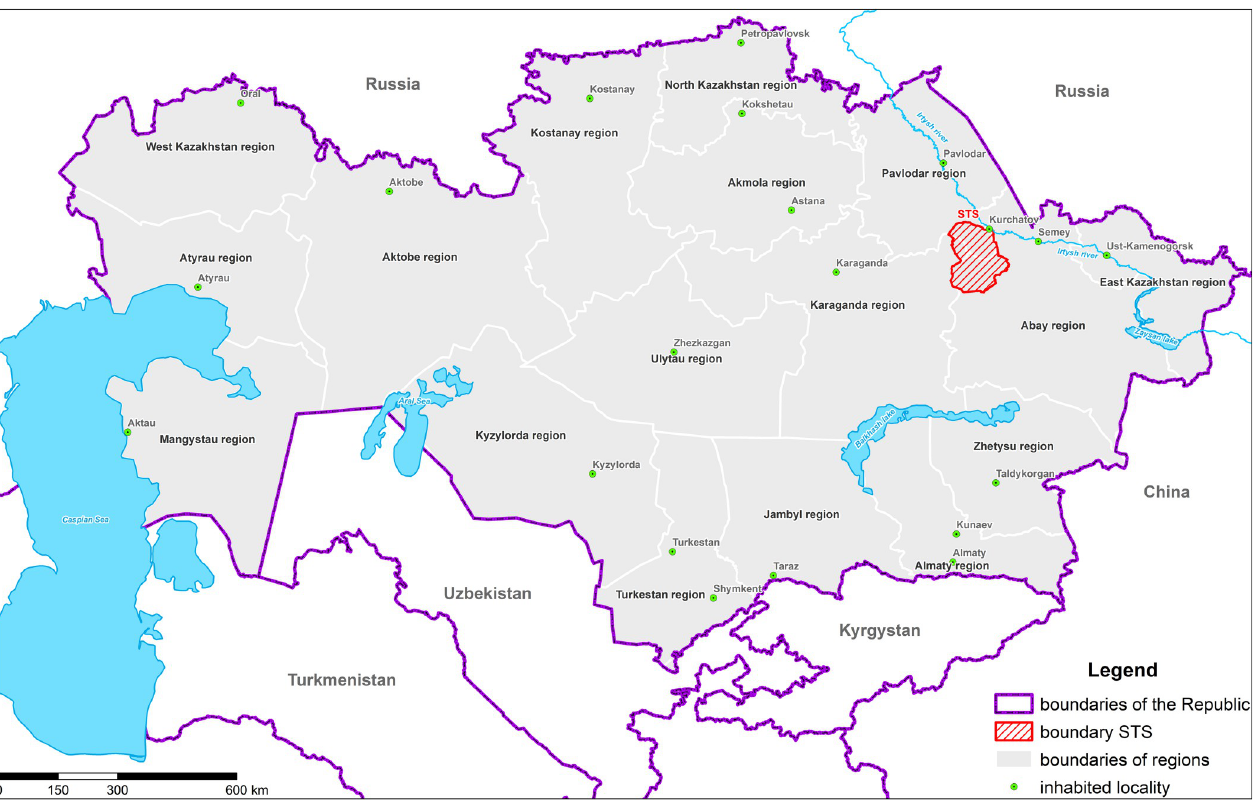
Fig 1. Schematic location of the STS territory in three regions of the Republic of Kazakhstan.